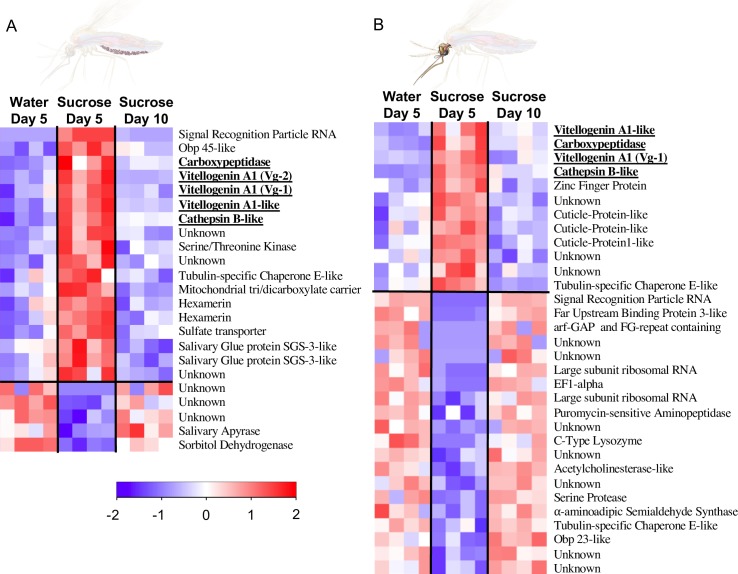
‘Vitellogenic wave’ in the fat body of young sugar-fed females.(A, B) Identification of candidate genes differentially expressed in females with low attraction to humans (sucrose day 5) compared to highly attracted females (water day 5 and sucrose day 10). Transcripts were considered differentially expressed with a log2-fold change ≥ 1 and a Benjamini–Hochberg FDR-corrected p-value < 0.05. (A) Differentially expressed genes (18 up-regulated, 5 down-regulated) in fat body transcriptomes (N = 4) of females with low attraction. Notably, 5 genes related to vitellogenesis, including 2 vitellogenin genes, were up-regulated (bold and underlined), reminiscent of the transcriptional response after a blood meal. (B) Differentially expressed genes (12 up-regulated, 20 down-regulated) in transcriptomes from the heads of females with low attraction (N = 4). Regarding the vitellogenesis-related genes, only the Vg-2 gene was specifically expressed in the fat body because the other genes were also differentially expressed in the heads (bold and underlined). arf-GAP, ADP-ribosylation factor–GTPase-activating proteins; FDR, False Discovery Rate; EFI-alpha, elongation factor 1 alpha; FG-repeat, phenylalanine-glycine repeat; Obp23, Odorant binding protein 23; Obp45, Odorant binding protein 45; SGS3, Salivary Gland Secretion 3; Vg, vitellogenin.